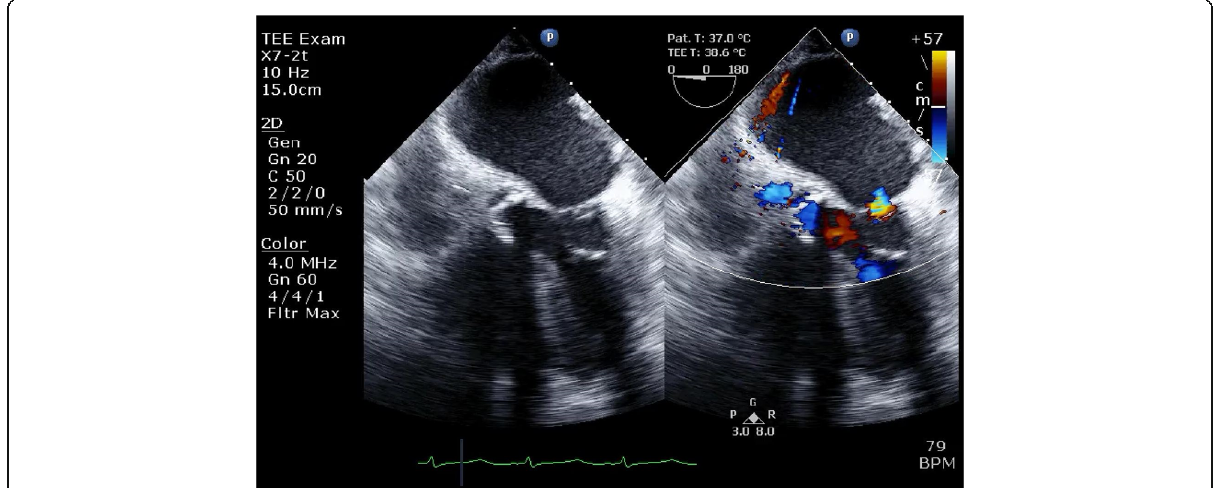
Fig. 3 Intraoperative transesophageal echocardiography images after Alfieri stitch was performed, showing a color Doppler image showing mild to moderate residual mitral